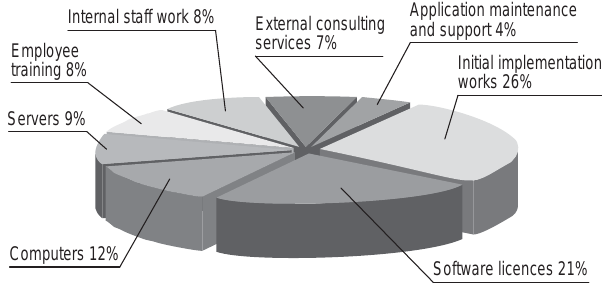
Fig. 3. CRS cost structure in Lithuanian